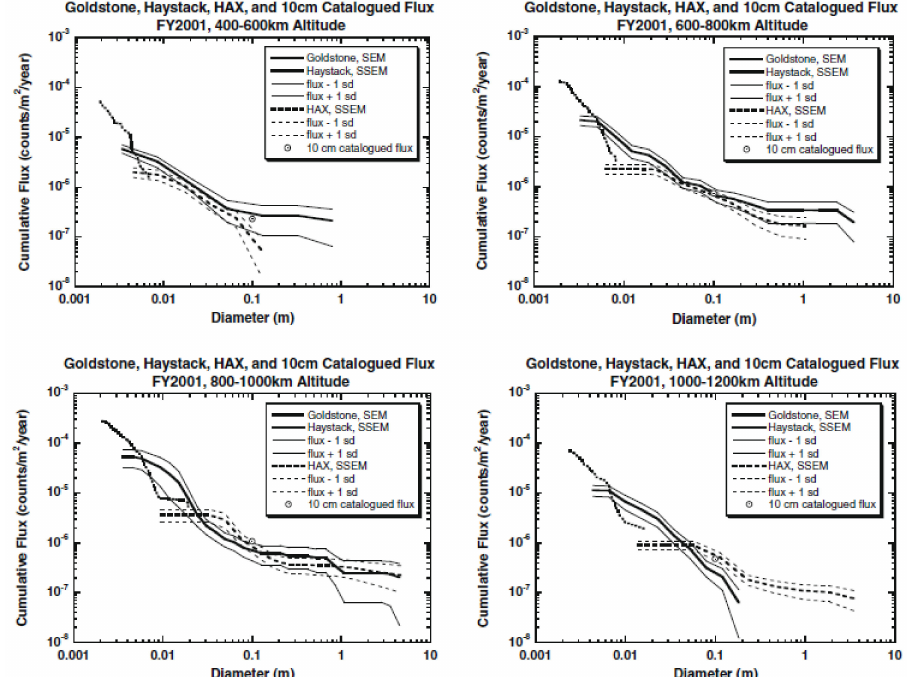
Figure 9. Debris flux versus diameter at different altitudes for the Goldstone, Haystack, HAX radars during fiscal year 2001 [22]. Reprinted from Advances in Space Research, Copyright 2009, with permission from